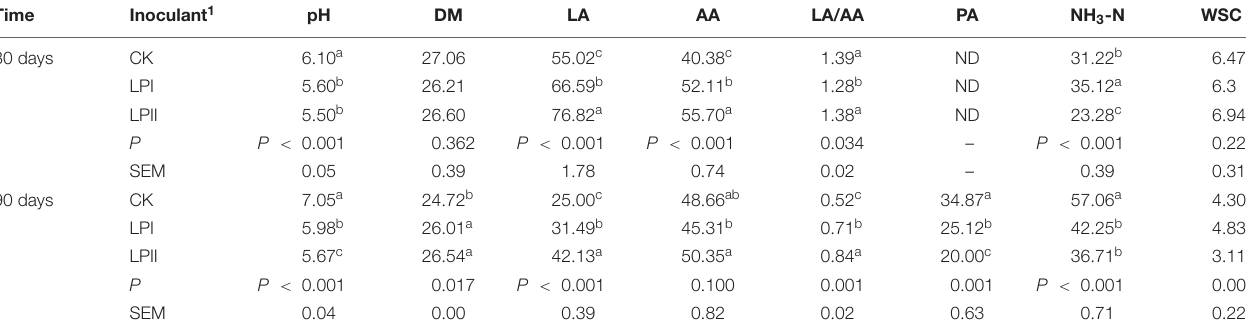
TABLE 1 | Fermentation end-products after different Lactobacillus plantarum treatments during alfalfa ensiling. Time Inoculant 1 pH DM LA AA LA/AA PA NH 3 -N WSC 30 days CK 6 . 10 a